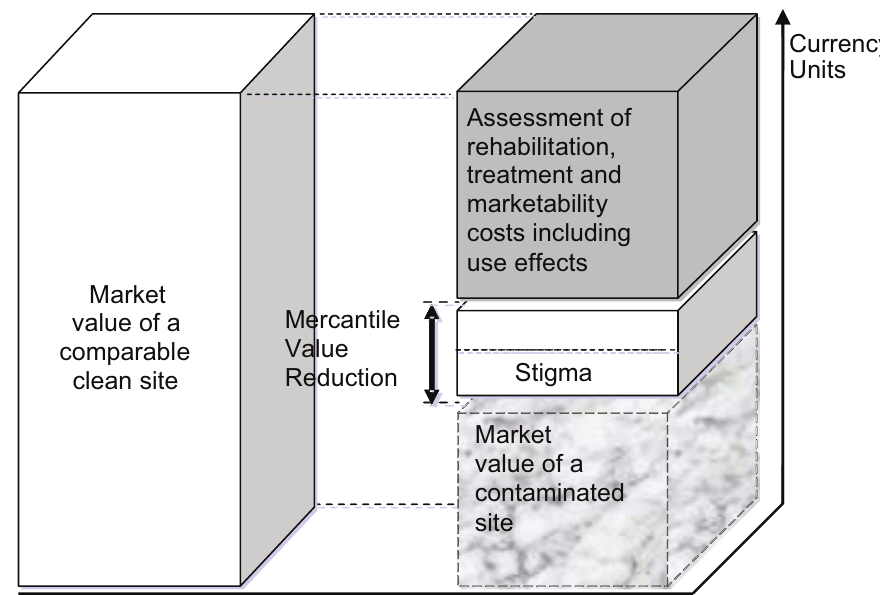
figure 1. effect of mercantile Value reduction on the market value of contaminated